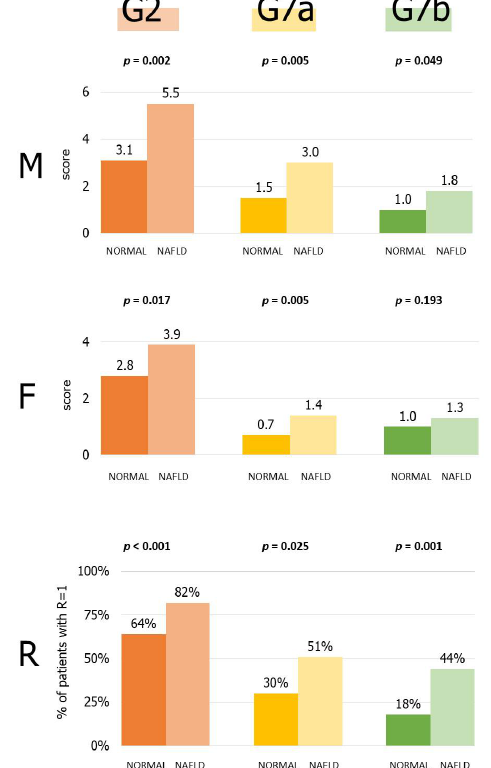
Figure 3. Recency (R), frequency (F), and monetary value (M) scores of bread/bakery (G2), salty (G7a), and sweet convenience products (G7b) in patients with and without nonalcoholic fatty liver disease (the latter category defined as “normal”).